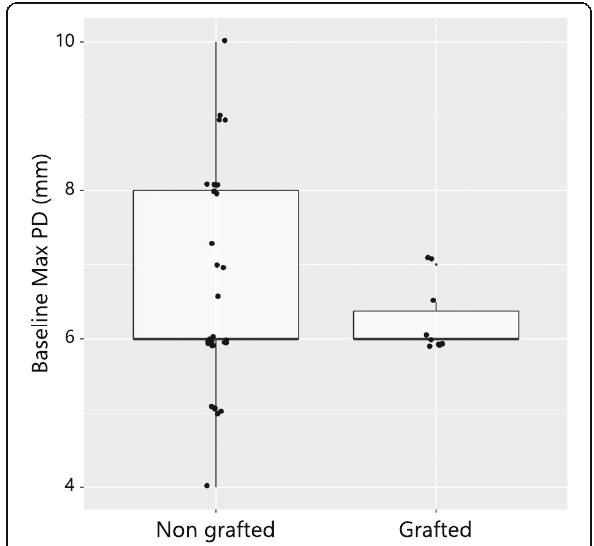
Fig. 2 Box plot depicting no significant differences of the baseline maximum PD values between the grafted and non-grafted patient groups ( p = 0.353)